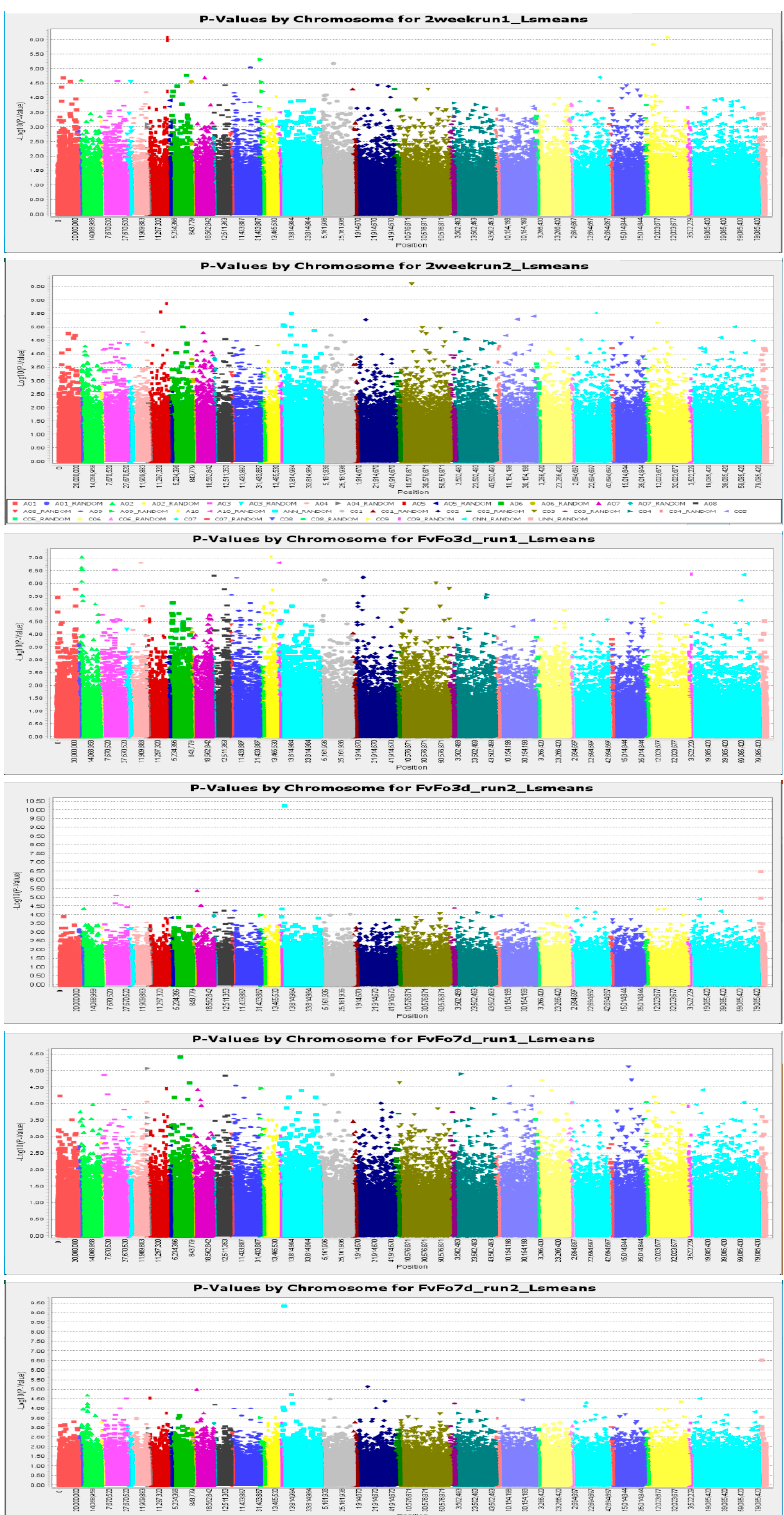
Figure 4. Manhattan plots for freezing tolerance. Manhattan plot of marker–trait association analysis using MLM with kinship and a PCA of 0 for the three phenotype response values (Fv/Fo at 3 days, Fv/Vo at 7 days, and visual damage score) under greenhouse conditions of 399 B. napus accessions. The X -axis is the chromosomes, and the Y -axis is the −